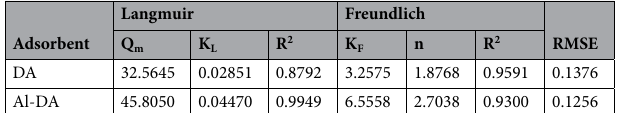
Table 1. Parameters of the isotherm models for F − uptake by DA and Al-DA.